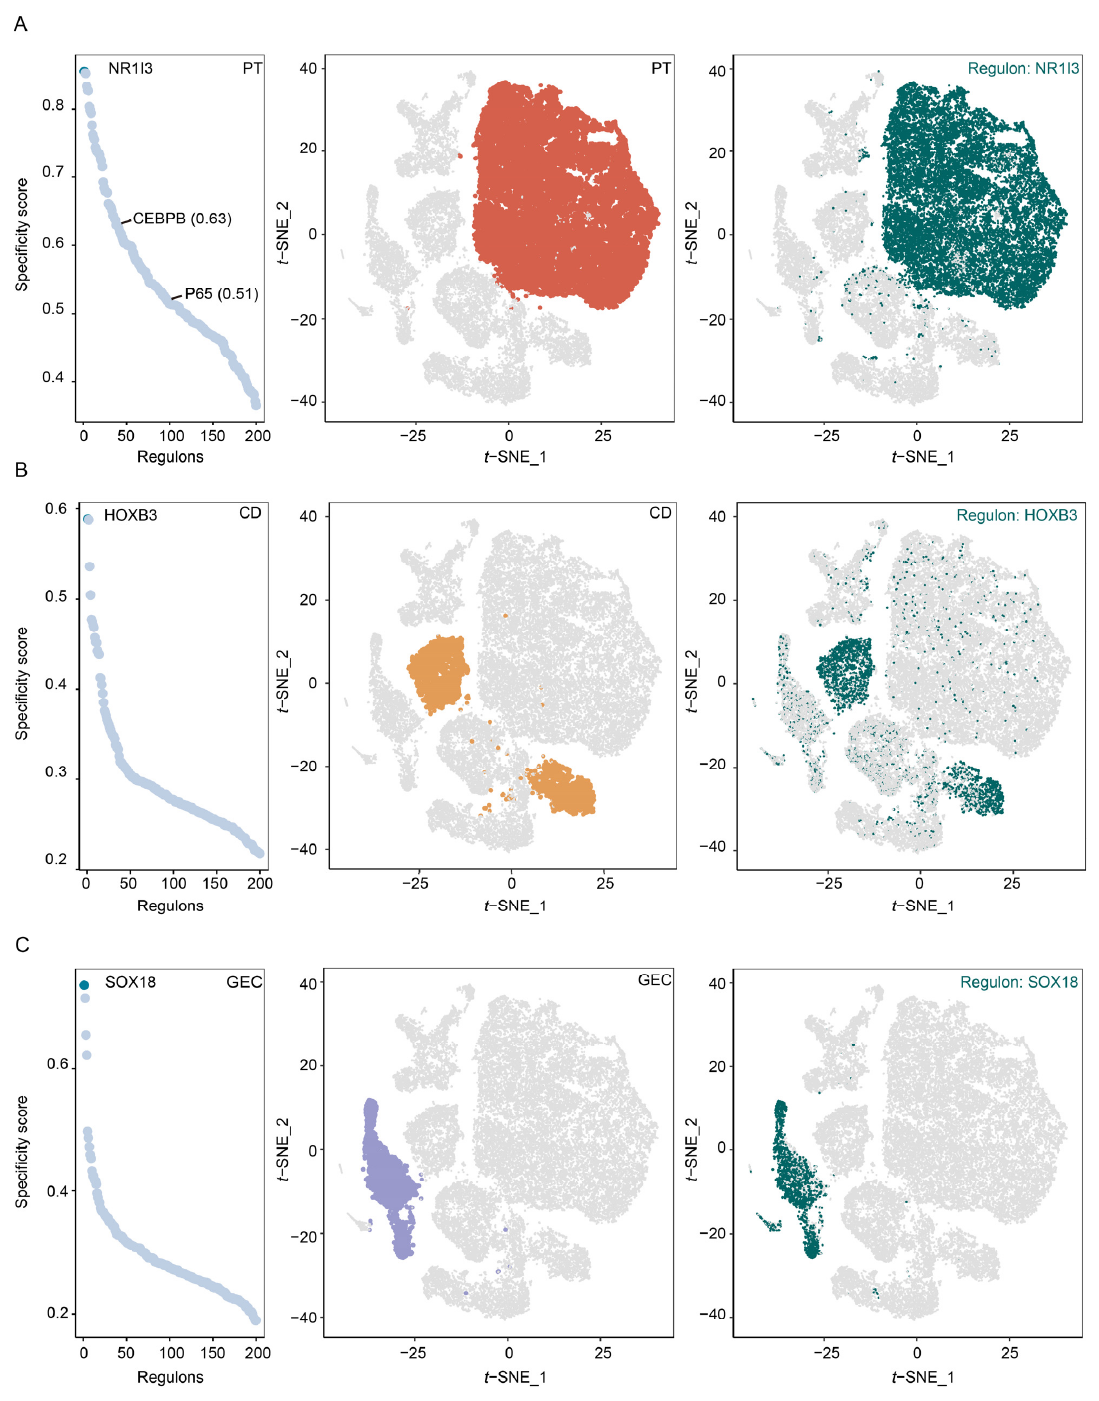
Figure 2. Analysis of the activity of cell type-specific transcription factors in normal kidneys. Rank for transcription factor (TF) in each cell type based on gene − TF regulatory networks specificity score ( A – C , left). PT, CD, and GEC were represented in the t-SNE plots ( A – C , middle). The color indicated cell type. Binarized TF activity scores for a listed first TF of each cell type on the t-SNE plot ( A – C , right). PT: proximal tubule cells, CD: collecting duct cells, GEC: glomerular endothelial cells.